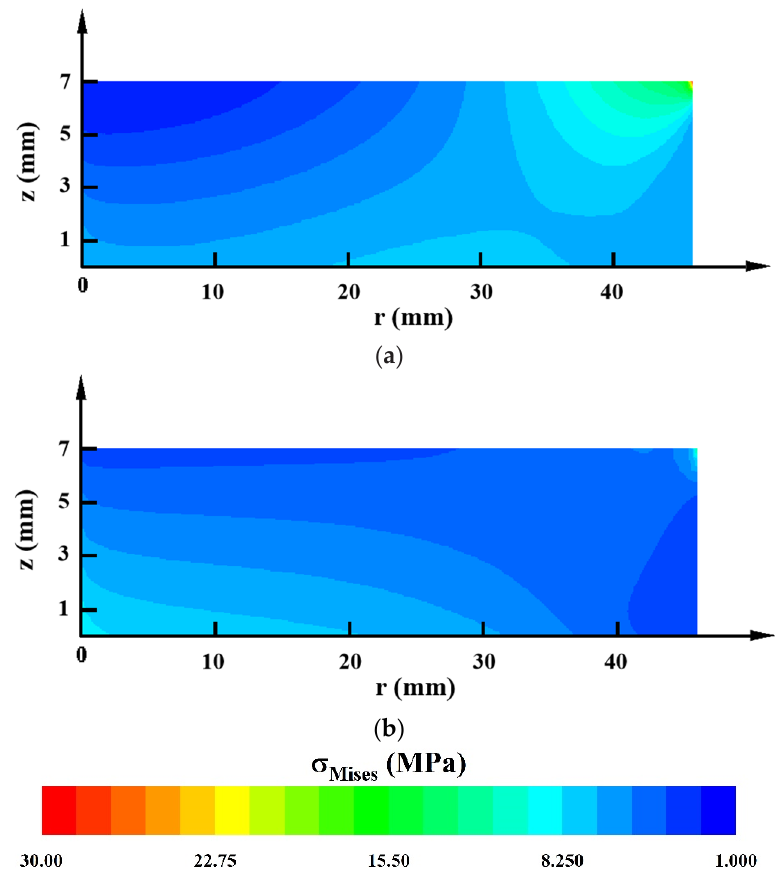
Figure 4. Distributions of thermal stress inside the AlN crystals grown in ( a ) Graphite crucible and ( b ) TaC crucible.